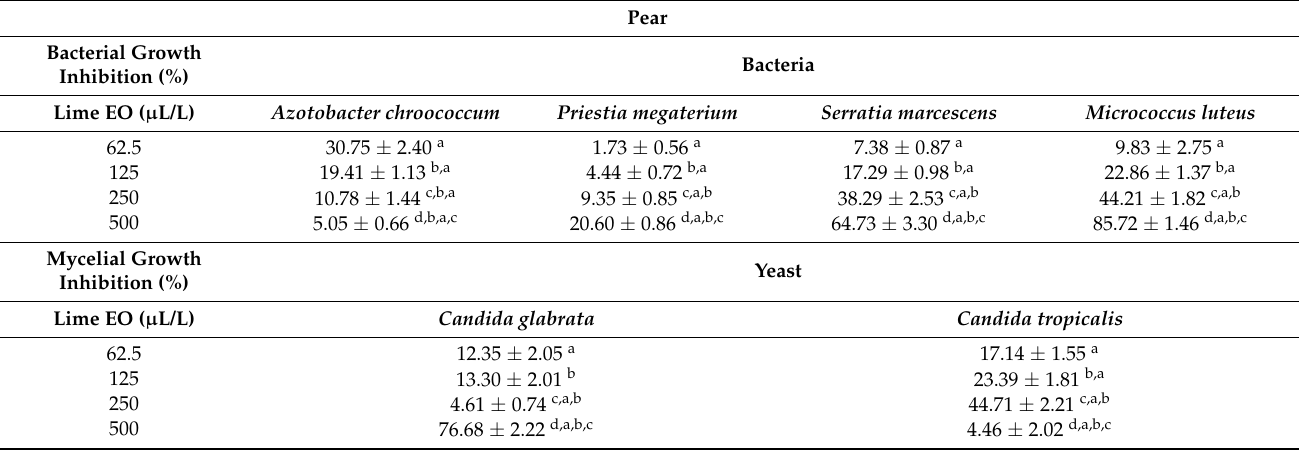
Table 4. In situ analysis of the antibacterial activity of the vapor phase of CAEO in pear.